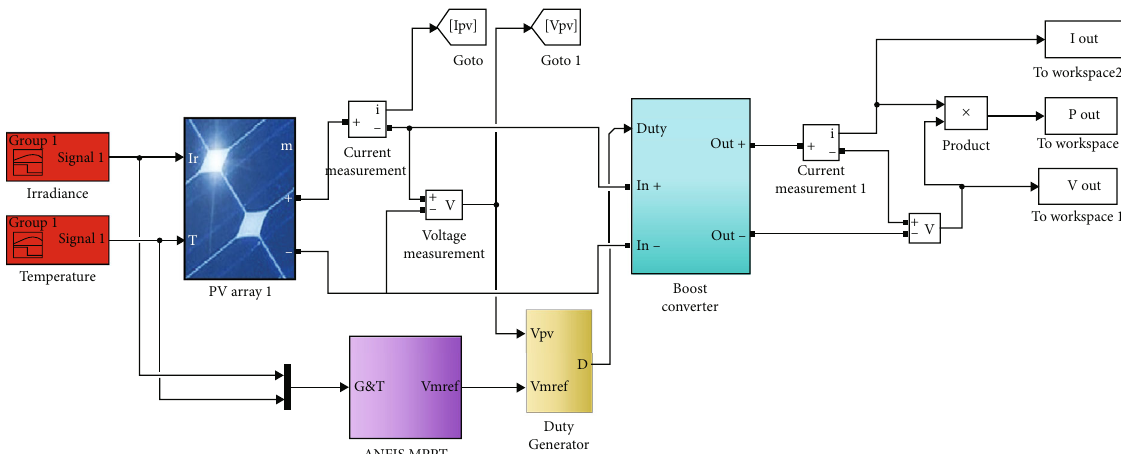
Figure 11: Simulink model of the power optimizer with ANFIS